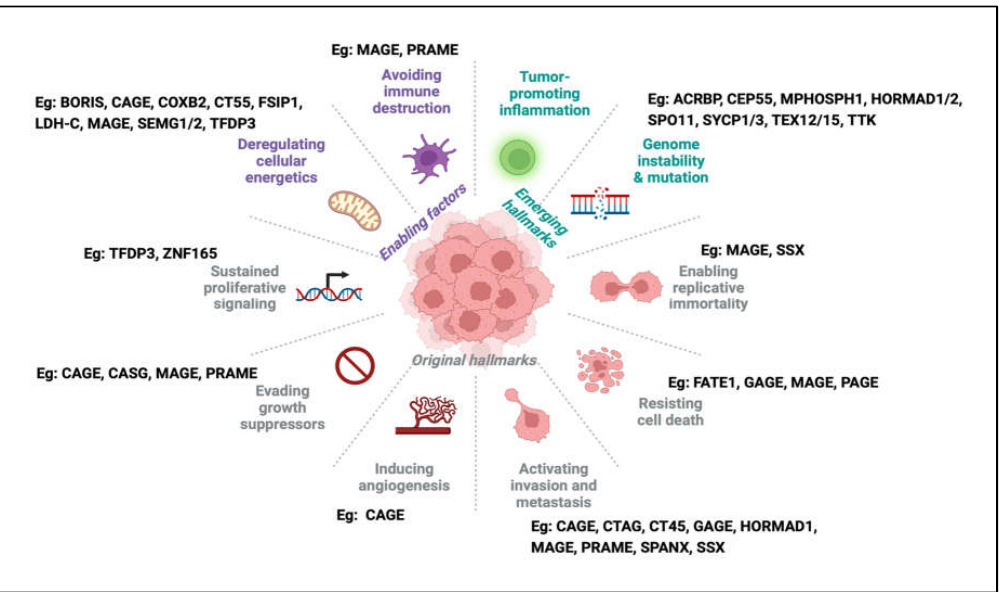
Figure 2. The hallmarks of cancer and examples of CTAs associated with each hallmark. In the latest update of the hallmarks of cancer, one can find examples of the involvement of CTAs in almost every hallmark, from original to newly emerging hallmarks.